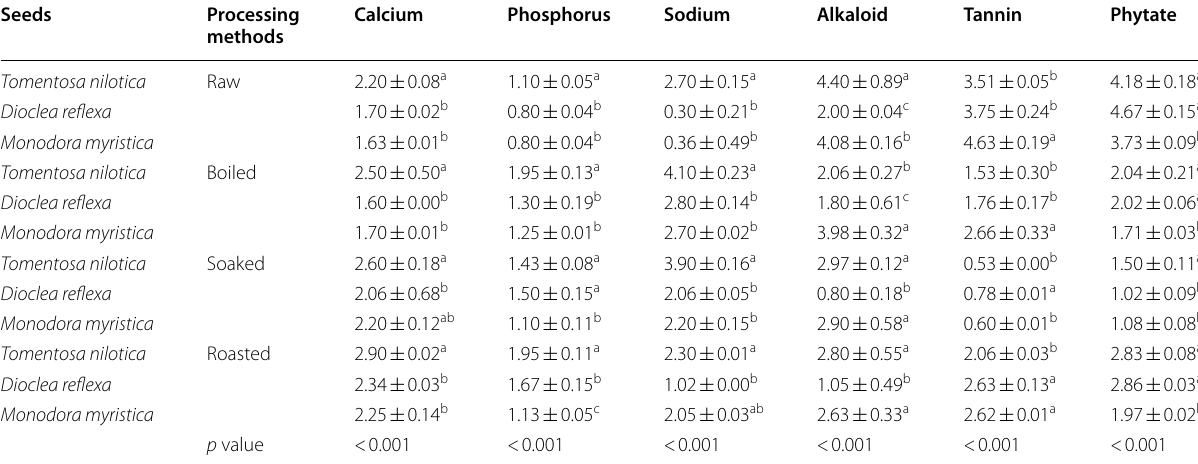
a ,b,c Means within the same row with different superscripts are significantly ( p < 0.05) different. n